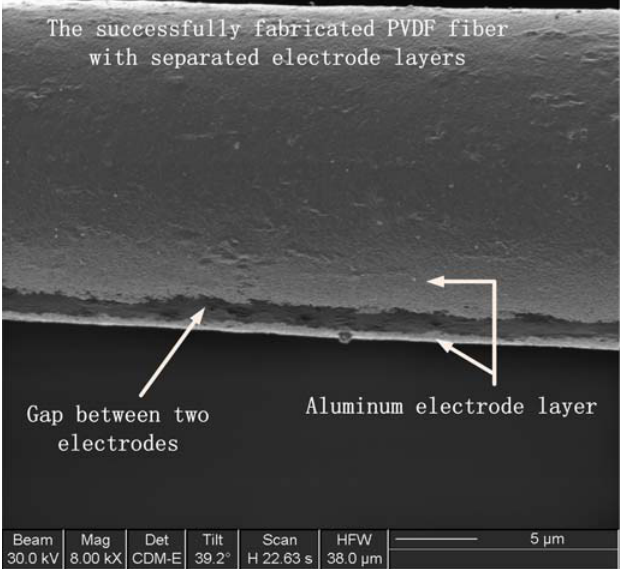
Figure 9. FIB image of the separated electrodes (the gap is about 1 µm) fabricated by thermo evaporation technique on a single PVDF micro/nano